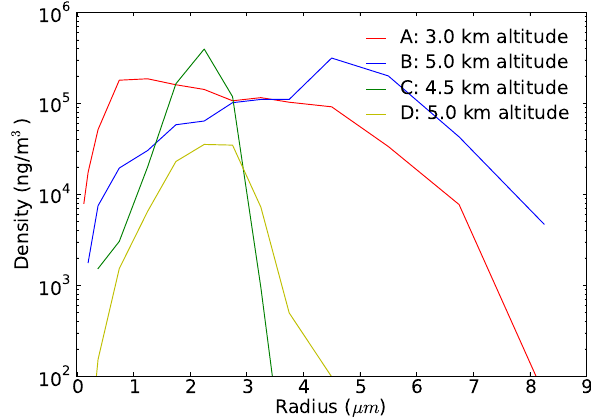
Fig. 9. The ash size distribution for locations A, B, C, and D (see top left panel of Fig. 5 for location). The size distributions are at the altitudes of maximum ash concentrations. Table 1. The total column densities and altitudes of uppermost layer with ash, ice or water for the four cases in Fig. 8. The modelled 10.8–12.0µm brightness temperature difference (BTD) for the four cases is given in the last column.